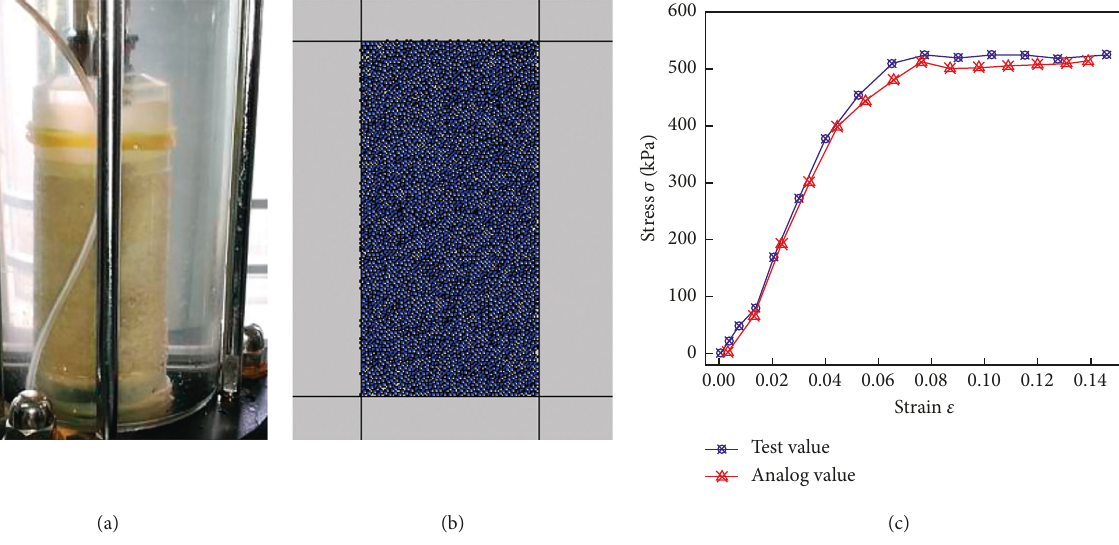
Figure 2: Parameter calibration.